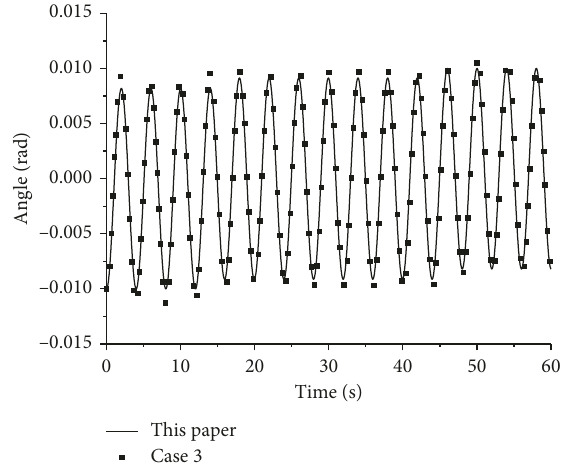
Figure 4: A comparison of the calculated results to reference [25] for the payload swing angle.